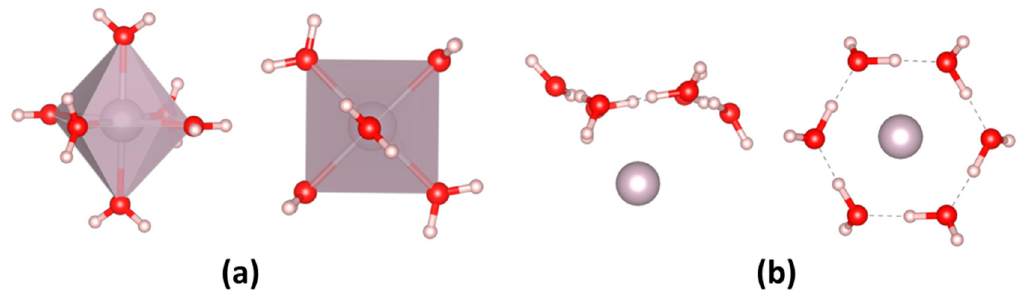
Figure 6. Side view and top view of the relaxed configurations of isolated ( a ) [Hg(H 2 O) 6 ] 2+ and ( b ) [Hg(H 2 O) 6 ] 0 complexes. Light pink, light magenta and red spheres represent H, Hg and O atoms, respectively. The polyhedra corresponding to bond generation are grey colored.